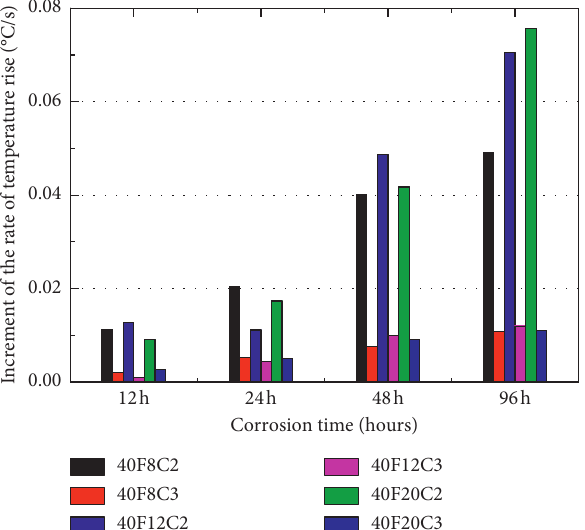
Figure 5: The incremental rate of temperature rise dependence on corrosion time for specimens with different concrete cover depths and different diameters of the internal steel bar.